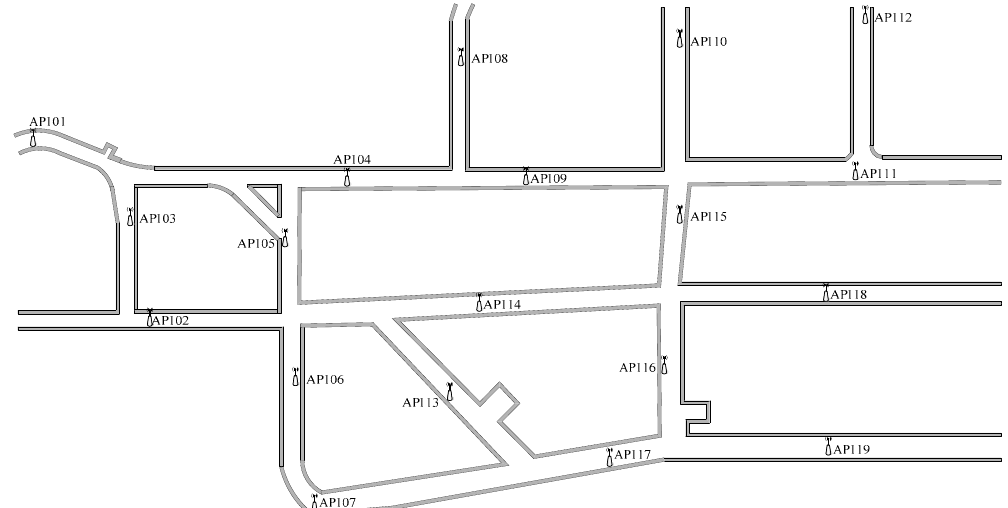
Figure 1. Diagram of underground AP deployment.